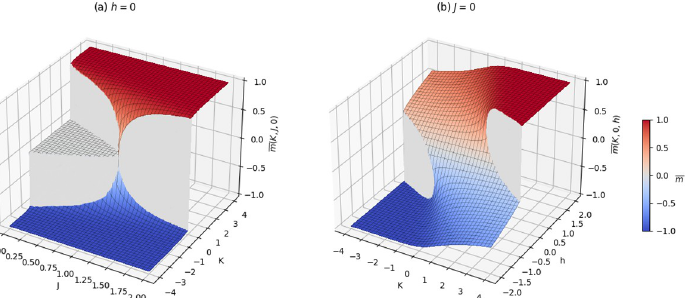
and when K = 0, we obtain the c